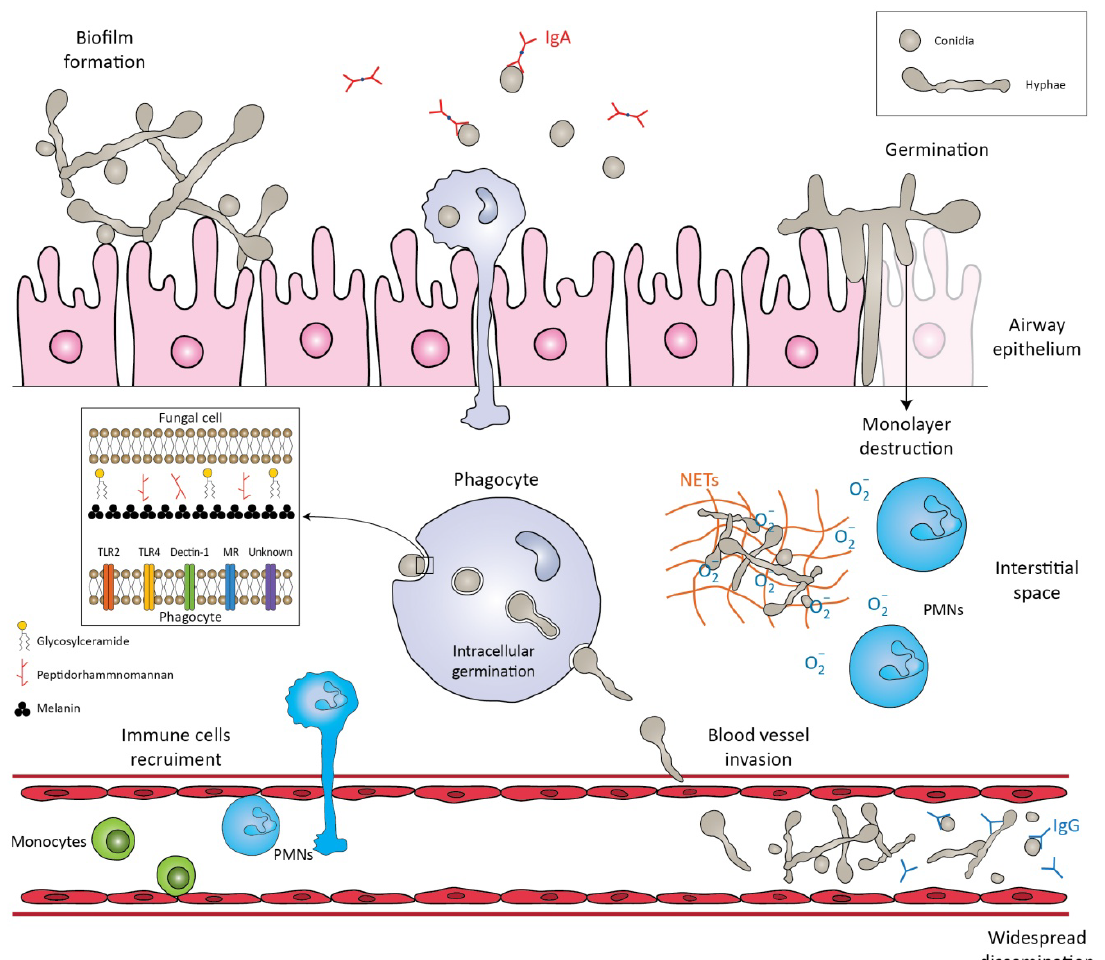
Figure 1. Schematic representation of the immune response against Lomentospora prolificans . The conidia are inhaled by the host. The mucociliary escalator and pulmonary alveolar macrophages can clear the conidia. If these primary mechanisms fail, the conidia transform into hyphae, a pro- cess called germination. The hyphae can form a biofilm, invade cell tissues/extracellular matrices, or destroy the monolayer of epithelial cells. Potential virulence factors in the fungal cell wall are peptidorhamnomannan, glycosylceramide, and melanin. Pattern recognition receptors (PRRs) that are involved in the recognition of fungus by phagocytes are TLR2, TLR4, Dectin-1, MR and other unknown receptors. Recognition of fungal molecules leads to the activation of immune cells in response to the microbial presence. Polymorphonuclears (PMNs) damage hyphae by degranulating reactive oxygen species (ROS) and by forming neutrophil extracellular traps (NETs). Even if phagocytosed, conidia can germinate inside phagocytes and penetrate their cell membrane. The hyphae can invade blood vessels and sporulate, leading to widespread dissemination. Salivary IgA exclusively recognizes the conidia, whereas serum IgG recognizes both forms of the fungus, co- nidia and hyphae.